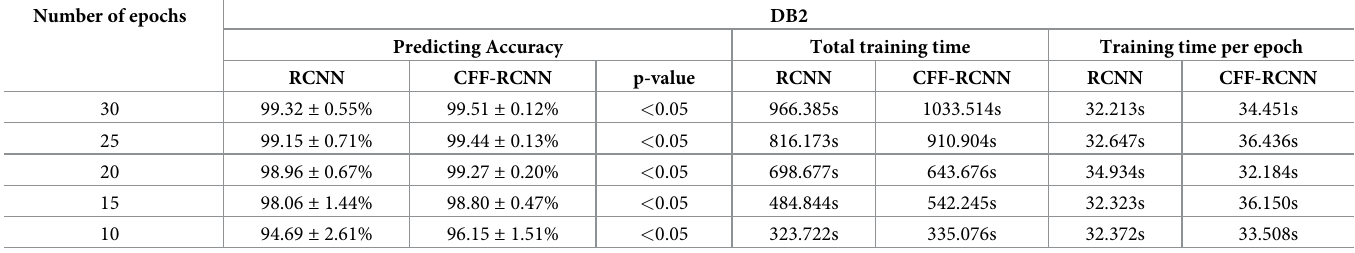
Table 5. Predicting accuracy, total training time, and training time per epoch of the RCNN and CFF-RCNN on DB2 at different epochs, along with the statistical analyses results. Number of